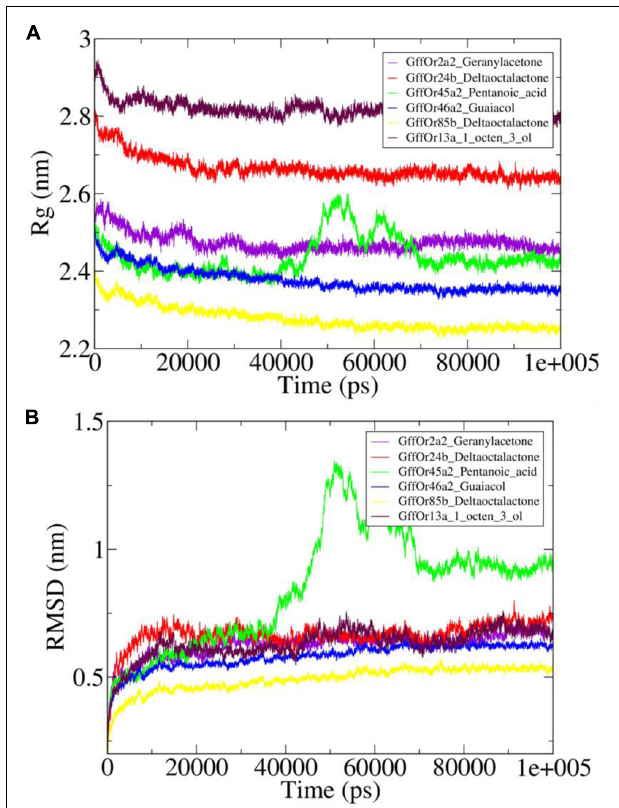
FIGURE 5 | The complexes stability assessment curves with (A) highlighting the changes observed in the pattern of the radius of gyration (Rg) and (B) illustrating the fluctuations in the patterns of root mean square deviation (RMSD)